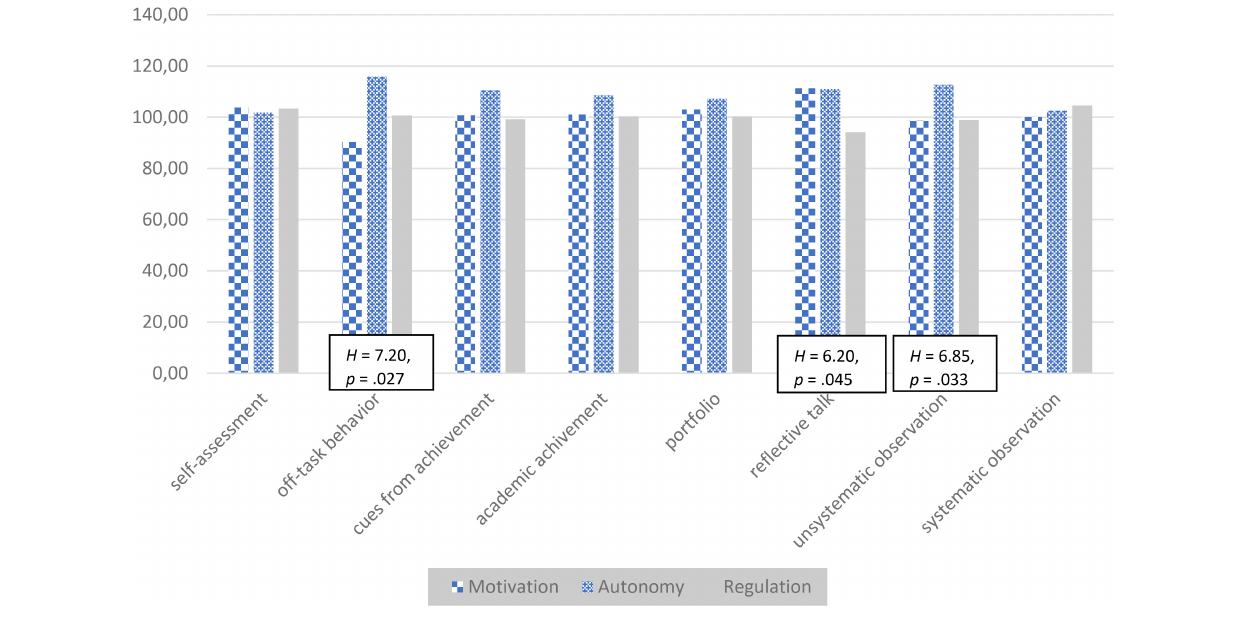
FIGURE 2 | Differences in ideas about SRL assessment between the three cluster groups as a result of a Kruskal Wallis test. Columns represent frequencies of codes of the 205 teachers sorted per cluster